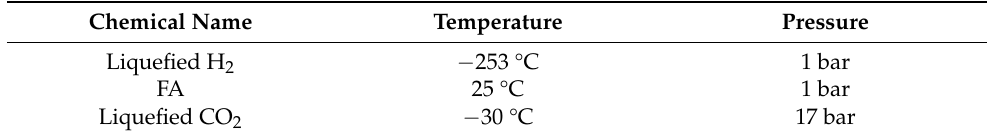
Table 4. Trailer conditions for the different chemicals